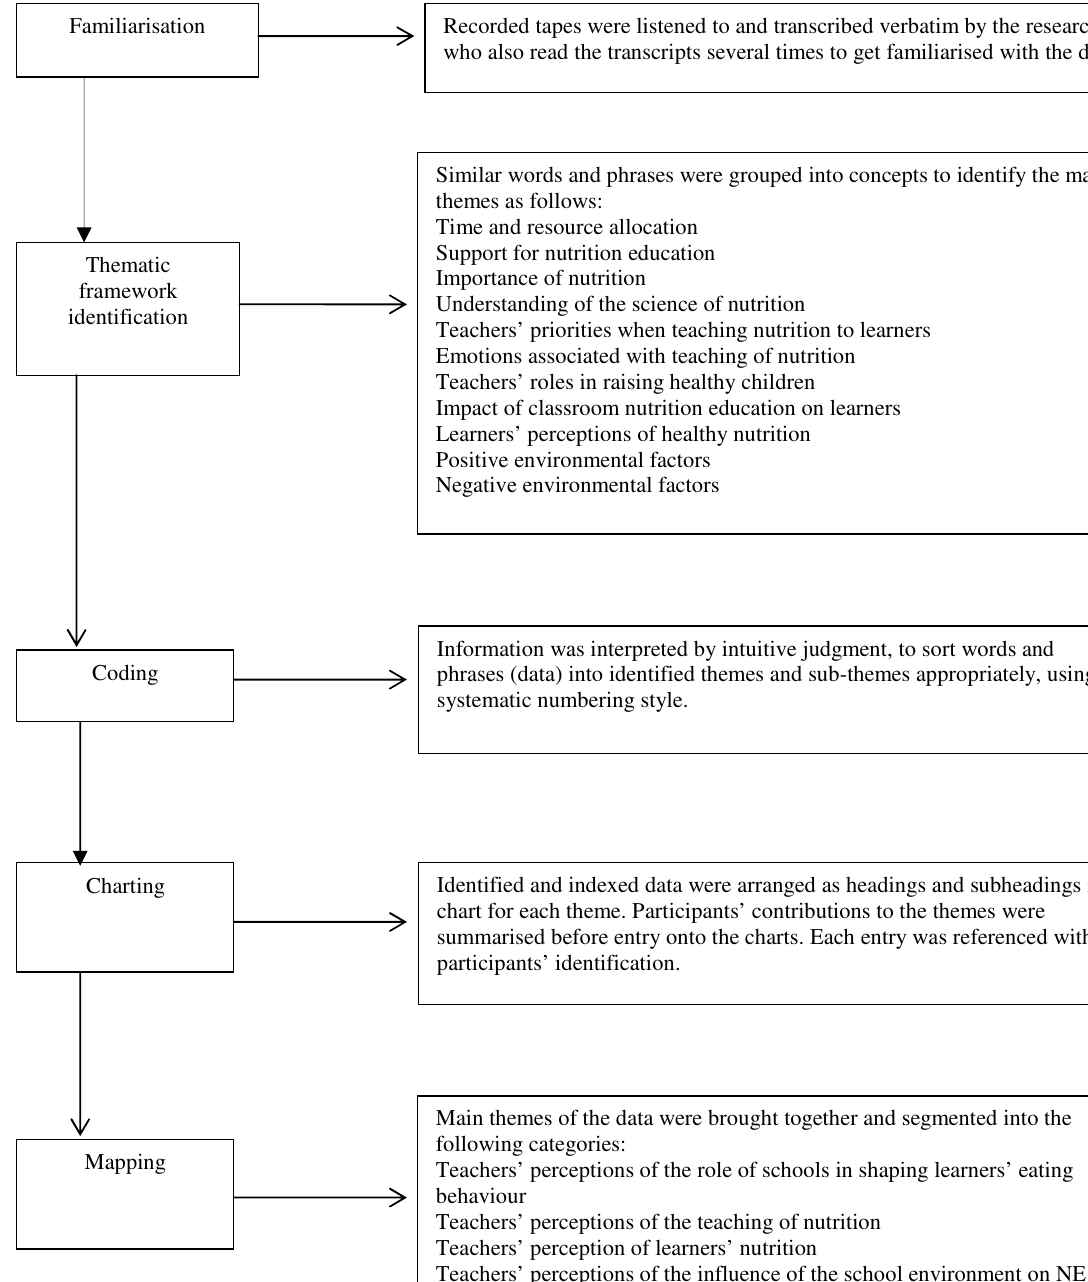
Figure 1 Flow-chart for the thematic approach of data analysis (Dixon-Woods, 2011; Ritchie